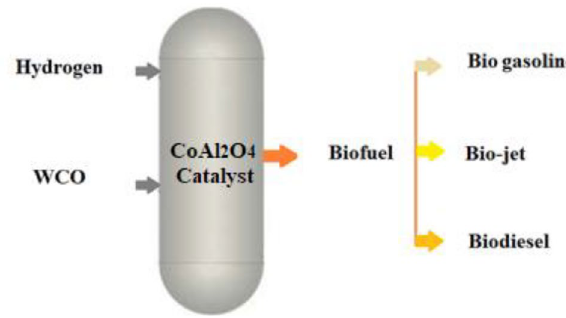
Figure 2. Graphical Summary of The Catalytic Activity